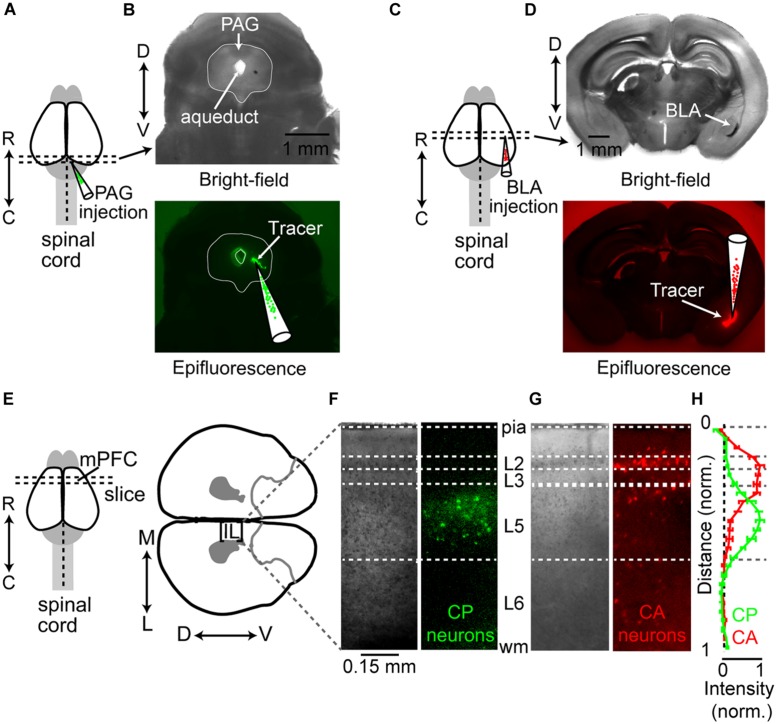
Differential distribution of CP and CA neurons in IL. (A) Schematic depicting the injection of fluorescent retrograde tracer into the PAG. Injection locations in the PAG were confirmed in coronal slices (300 μm) visualized using both bright-field (B, top) and epifluorescence (B, bottom) imaging. (C) Schematic depicting the injection of retrograde fluorescent tracer injection into the basolateral amygdala (BLA). (D) Bright-field image (top) of coronal brain slice (300 μm) containing the BLA and the corresponding epifluorescence image (bottom) confirming the location of retrograde tracer injection. (E) At least 2 days following tracer injection, coronal slices (300 μm) containing the mPFC were prepared (left) and oriented so that the pia of the IL cortex was horizontal in the imaging chamber (right). Bright-field and epifluorescence images showing laminar location of retrogradely labeled (F) CP neurons and (G) CA neurons in IL cortex. (H) Normalized fluorescence intensity (mean ± SEM) of soma location as a function of normalized cortical distance [where pia = 0 and white matter (wm) = 1] for CP (n = 10) and CA (n = 7) neurons in IL cortex. Rostral-caudal: R↔C; dorsal-ventral: D↔V; lateral-medial: L↔M.